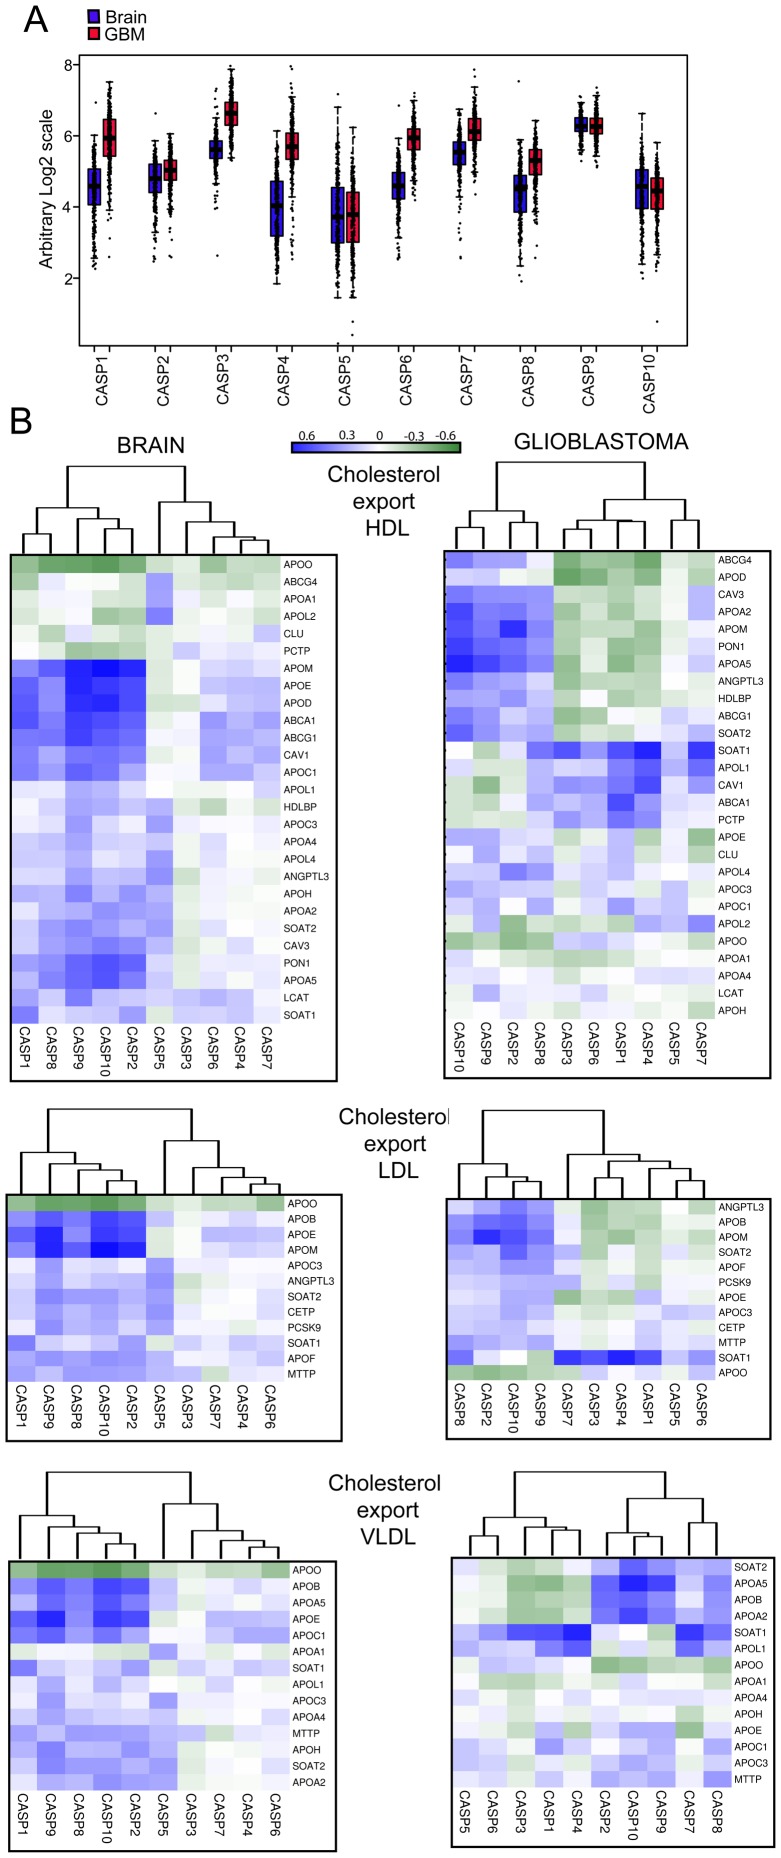
Co-expression analysis of caspases and cholesterol genes in human brain and GBM.A. Expression levels of the different caspases in GBM and in the normal brains. Box plots depicted in red mark tumors whereas blue was used for normal brain. mRNA levels of CASP1, CASP3, CASP4, CASP6, CASP7 and CASP8 were significantly augmented in tumor samples. p-value <2.2e-16. B. Correlations of expression levels between caspases and cholesterol genes in different brain and GBM samples in Cholesterol export, lipoproteins category. Data obtained were used to calculate the correlation values with the Pearson method. In the heat map positive values are displayed in blue and negative in dark green. The dendrograms displayed on the top are based on hierarchical clustering using the complete linkage method.